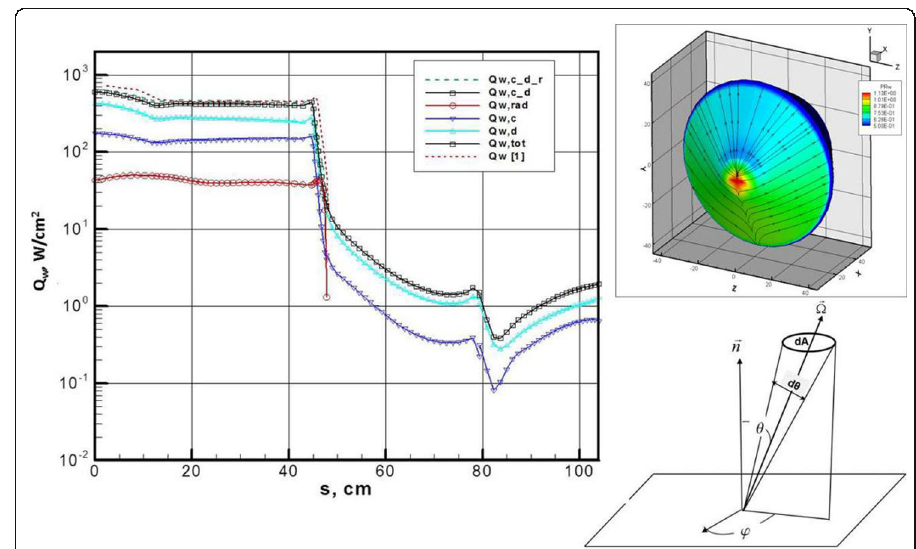
Fig. 13 Heat transfer distribution over the Stardust probe in